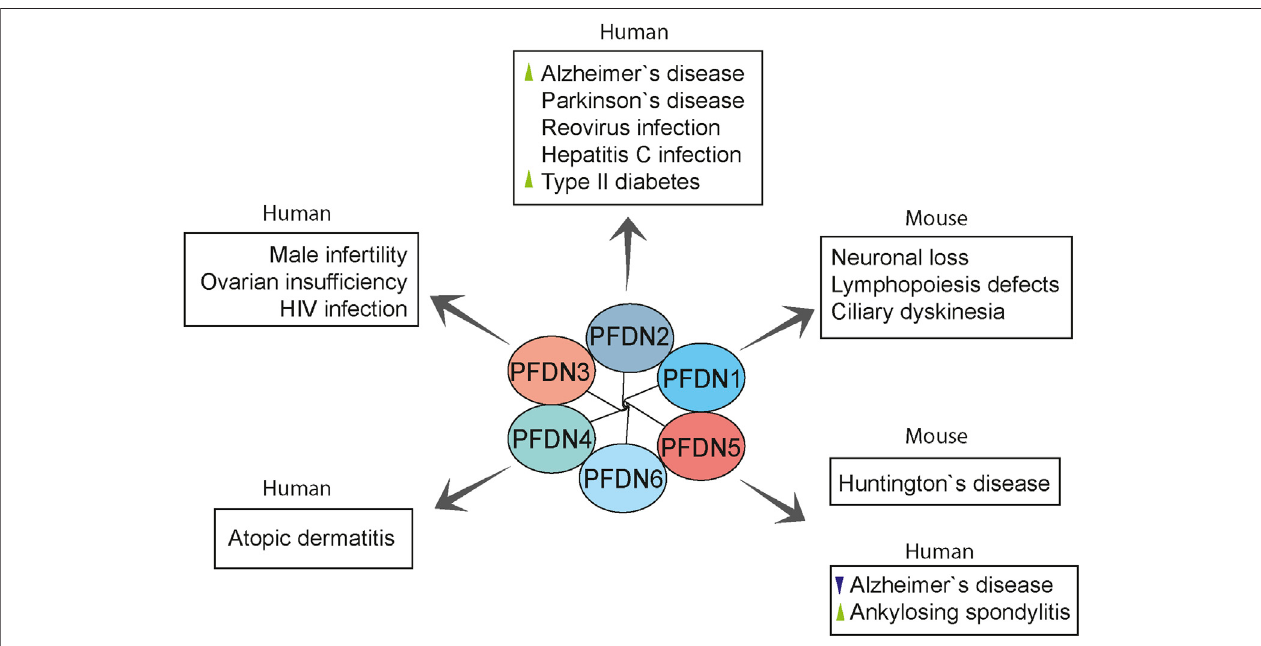
FIGURE 5 | Overview of prefoldin-mediated diseases in humans and mouse models. Prefoldin subunits are involved in various pathologies other than cancer. PFDN2 and PFDN5 were linked with neurodegenerative diseases. PFDN2 and PFDN3 mediate some virus infections. Moreover, prefoldin subunits have distinct roles in theprogressionofrareanomalies.Changesinprefoldin subunitregulationinhumandiseasesareindicatedwitharrowhead(green,upregulation;violet,downregulation).